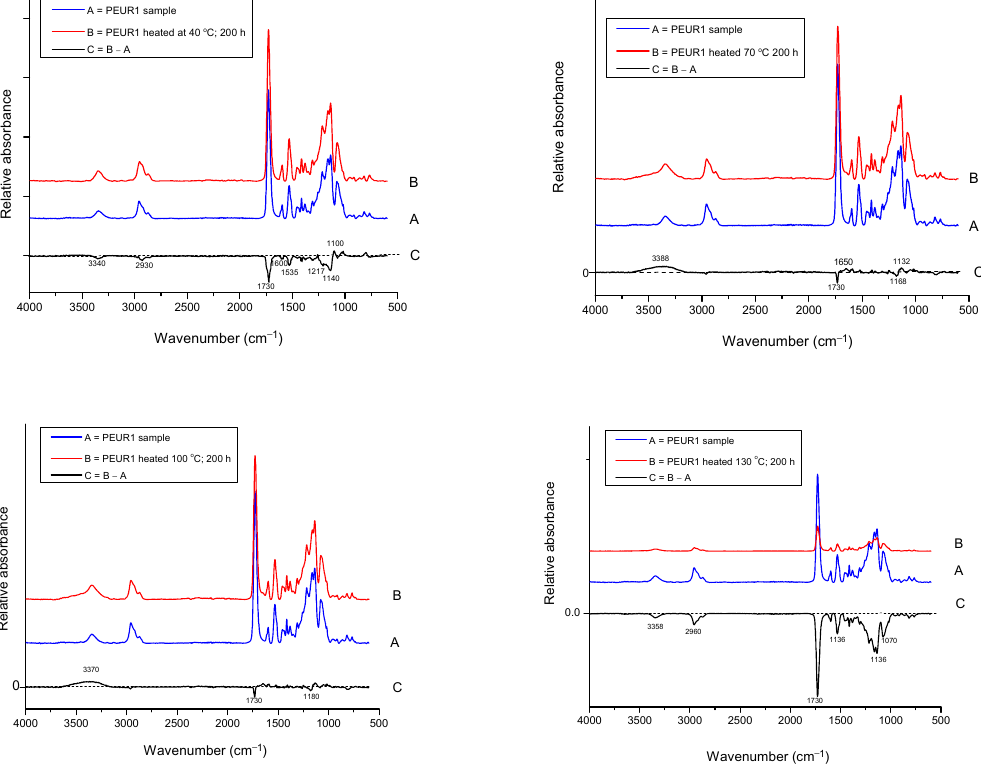
Figure 10. FTIR spectra of PEUR1 before and after thermal aging 200 h at: 40, 70, 100 and 130 ◦ C and the difference